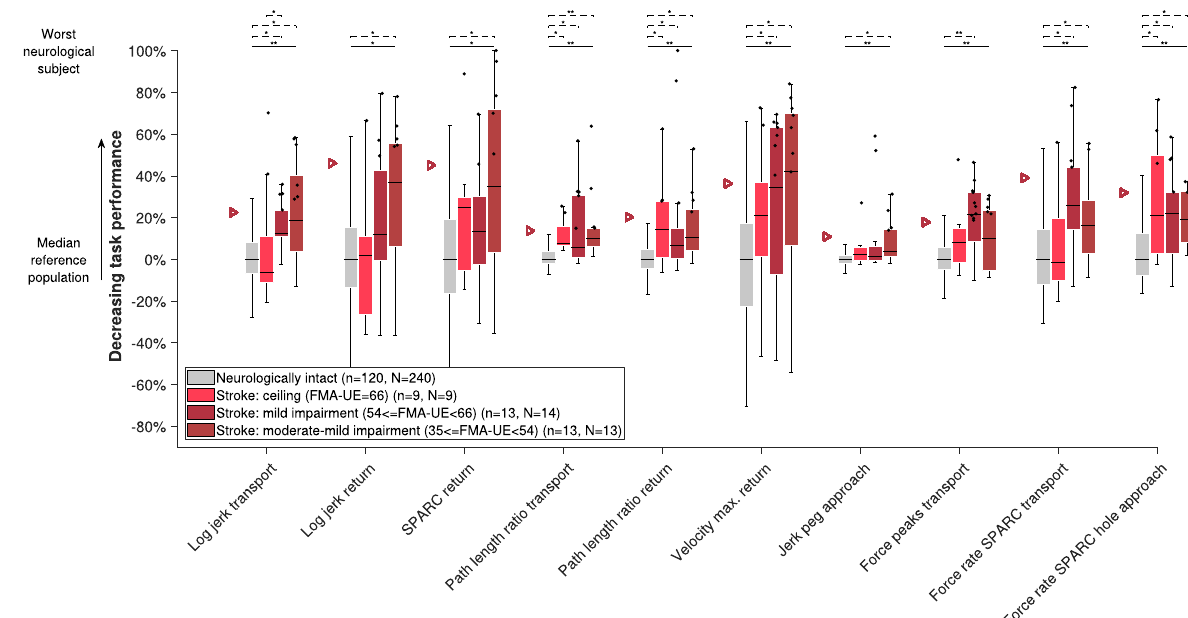
Fig. 4 Sensitivity of metrics to disability severity in stroke subjects. Subjects were grouped according to the clinical disability level. The vertical axis indicates task performance based on the distance to the reference population. The population median is visualized through the black horizontal line, the interquartile range (IQR) through the boxes, and the min and max value within 1.5 IQR of the lower and upper quartiles, respectively, through the whiskers. Data points above the 95th-percentile (triangles) of neurologically intact subjects are showing abnormal behavior (black dots). Solid and dashed horizontal black lines above the box plots indicate results of the omnibus and post-hoc statistical tests, respectively. *Indicates p < 0.05 and ** p < 0.001. n refers to the number of subjects in that group and N to the number of data points. Only subjects with available clinical scores were included. For the jerk peg approach, one outlier was not visualized to maintain a meaningful representation. FMA-UE Fugl-Meyer upper extremity, SPARC spectral arc